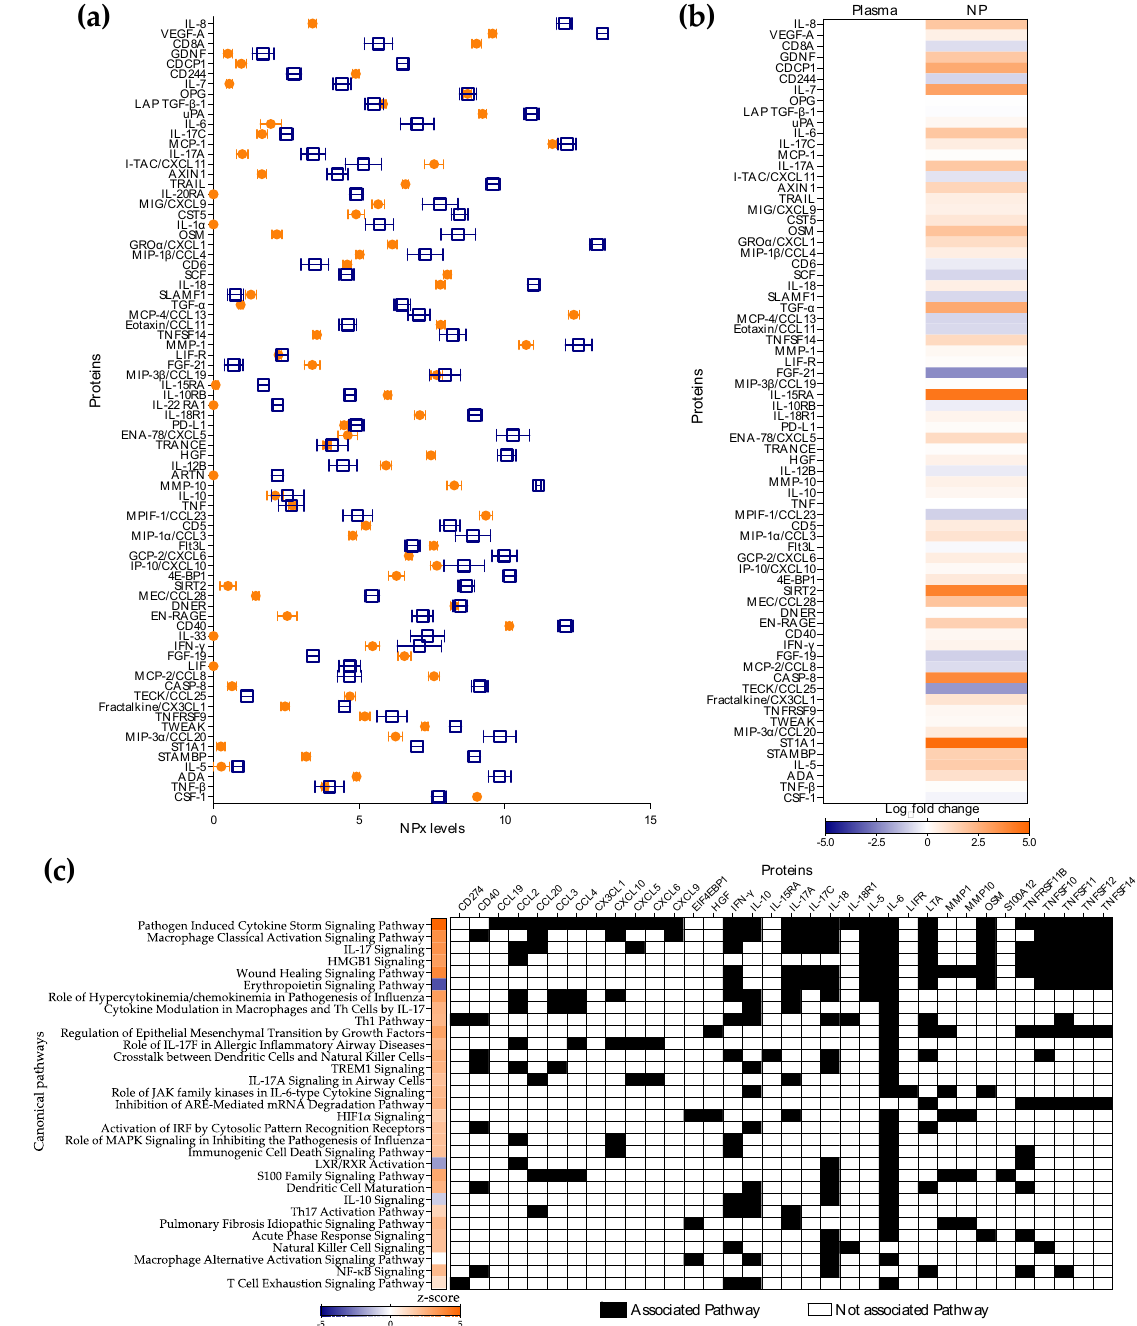
Figure 1. Comparison of systemic and nasopharyngeal (NP) secretion proteomic profiles. Plasma and nasal swabs were obtained from each study participant. Plasma was analyzed undiluted. NP secretions were collected from swabs and analyzed undiluted. ( a ) Normalized protein expression (NPx) levels in plasma ( ) and NP secretions ( ) were measured via Olink technology. Compara- tive Luminex/Olink nomenclature is shown. ( b ) Heatmap representing upregulated (orange) or downregulated (blue) proteins in NP secretions vs. plasma. Differences are shown in Log2 from single replicates for each participant. ( c ) Canonical pathways significantly enriched in NP secretions in comparison to plasma. The activation z-scores determined by directionality (overabundance in orange and underabundance in blue) and number of proteins are represented by a heat map. The proteins associated to each pathway are shown in black cells. The pathways included had a minimum of two associated analytes and a p < 0.05 (right-tailed Fisher exact